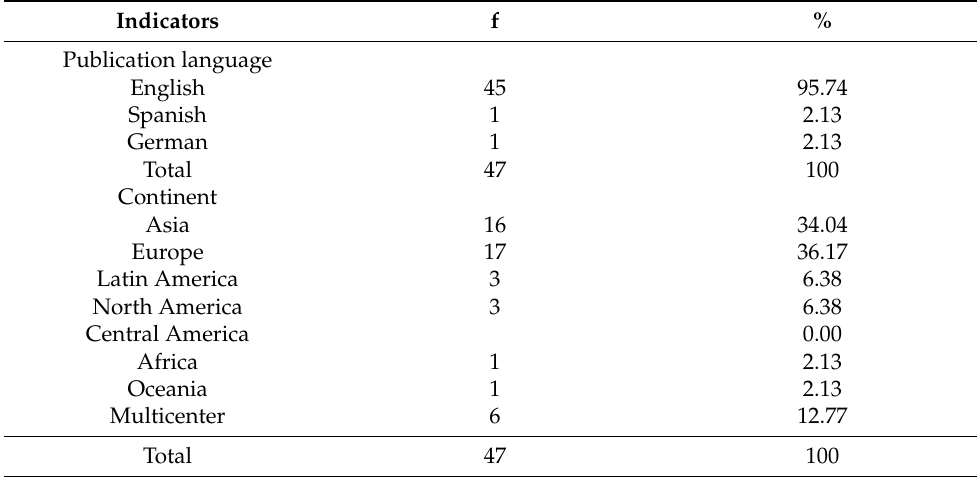
Table 1. Characteristics of the bibliometric indicators